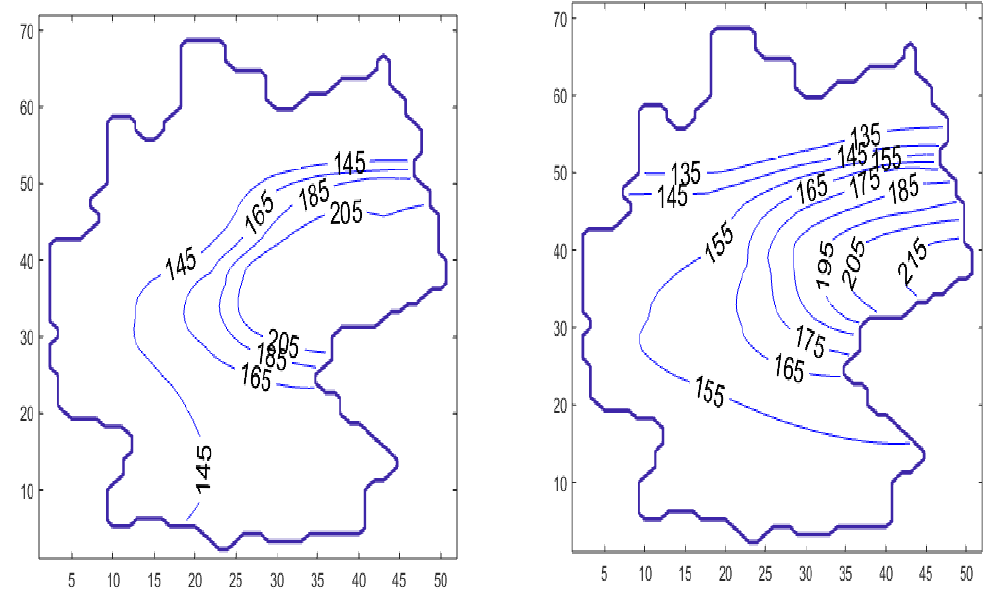
Figure 3. Contour lines of the seven-day incidence, s , at the time t = 15 days ( left panel ), and t = 125 days ( right panel ).